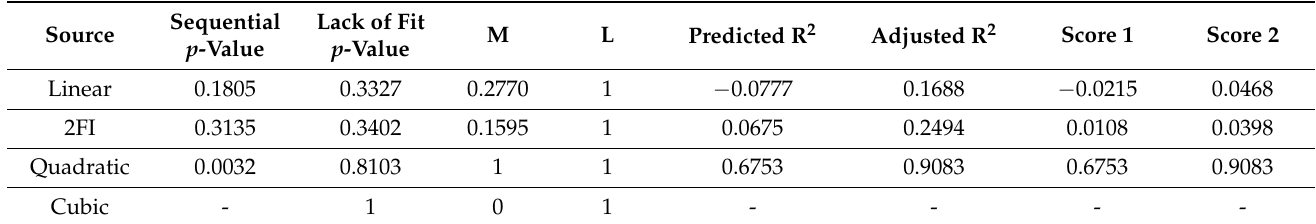
Table 2. Fit summary with calculated Whitcomb Scores 1 and 2 for the response—HER rate.